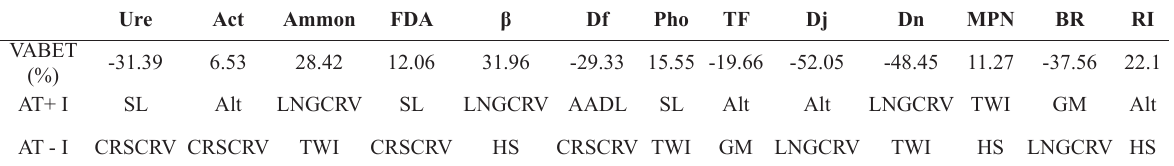
Most important terrain attribute (AT + I) and less important terrain attribute (AT - I) to explain variation in microbiological attributes urease (Ure), actinobacteria (Act), Ammonifiers (Ammon), activity of the FDA (FDA), β-glucosidase (β), free-living N -fixing bacteria detected from FAM (Df) medium, NFB (Dn) and JNFB (Dj), phosphatase 2 (Pho), total fungi (TF), most probable number of native rhizobia (MPN), basal respiration (BR), substrate-induced respiration (RI), and percentage of this variance explained by terrain attributes